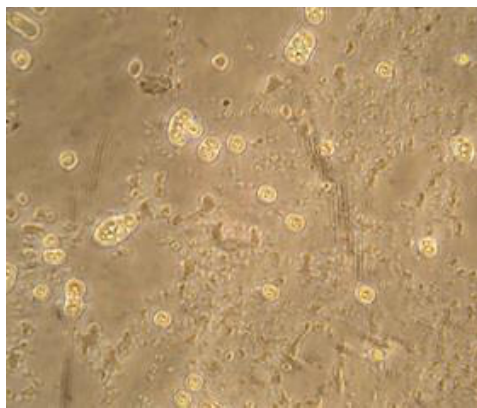
Figure 1. Percentage distribution of samples above and below target values for HPCs at 22 °C (100 CFU/mL or less), HPCs at 36 °C (10 CFU/mL or less), and P. aeruginosa (<1 CFU/100 mL) in tap water and hand-piece water.